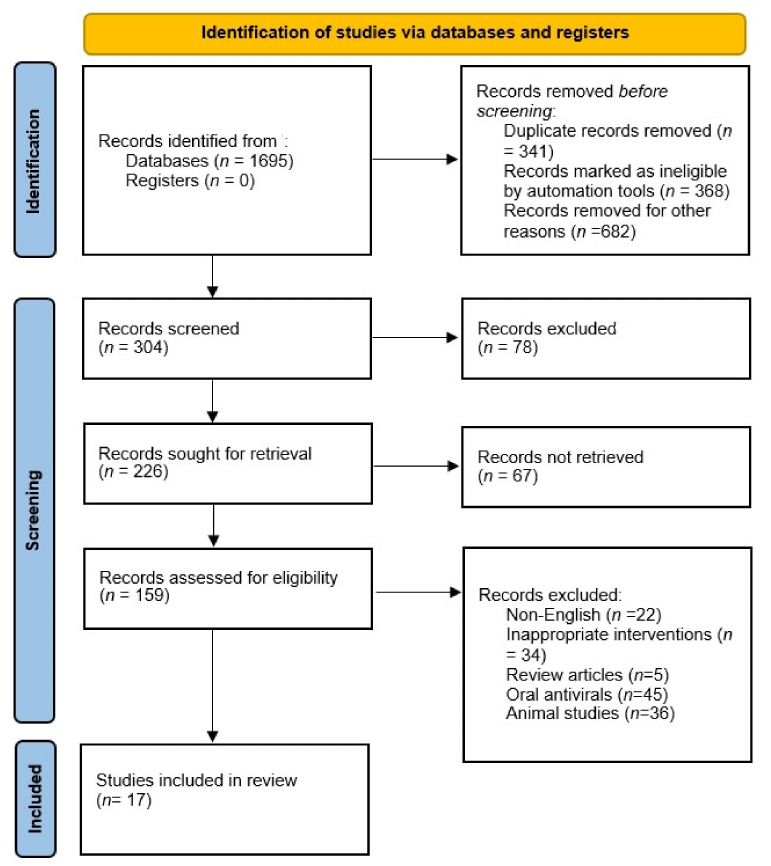
Figure 1. Flow chart of included studies. Table 2. Main characteristics of studies on inhaled antiviral